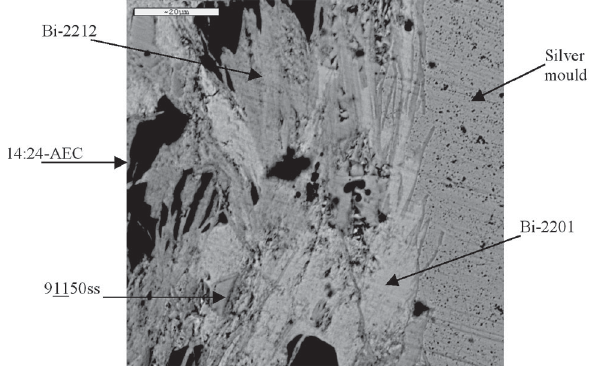
Figure 6. SEM micrograph of the microstructure of PMR obtained bulk Bi Sr Ca Cu O illustrating presence of (Sr,Ca) 2+x 3-y y 2 8+ ∆ (14:24-AEC).